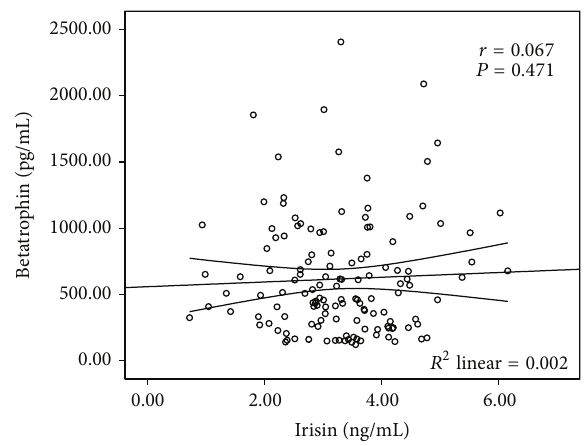
Figure 3: Correlation between irisin and betatrophin levels in T2DM